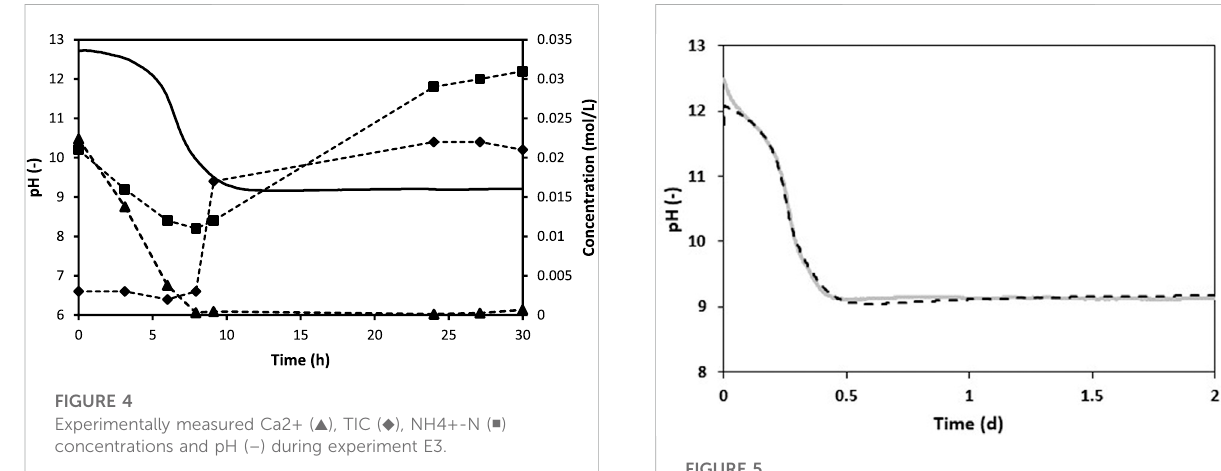
FIGURE 5 SimulatedpH( ╍ )forexperimentE3.Allparameterswere fi tted in respect to the experimentally measured pH ( –